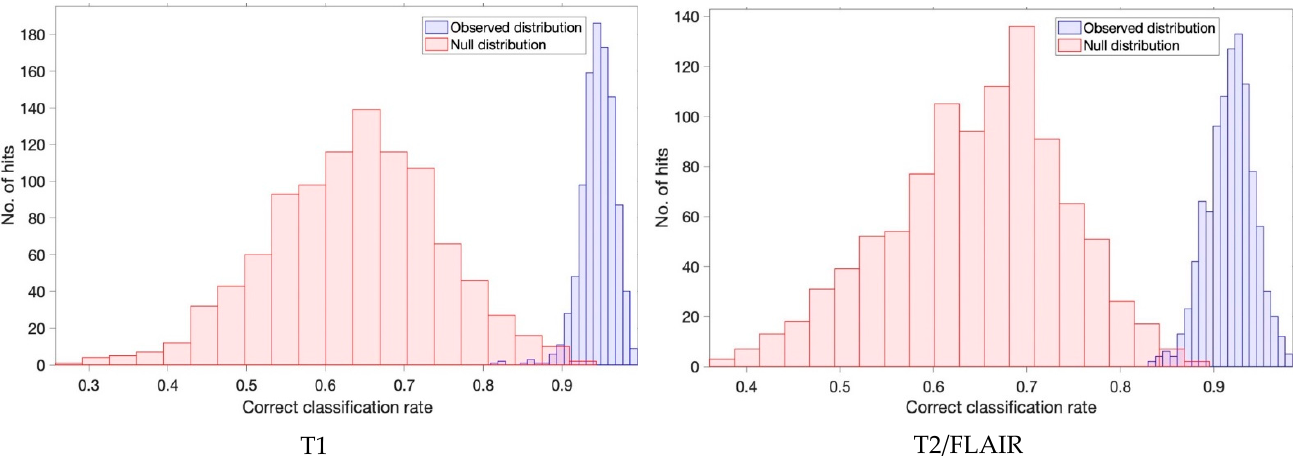
Figure 2. ROC curves with AUC for T1 and T2/FLAIR patient classification over nine repeats and 51 iterations with the partial least squares-discriminant analysis (PLS-DA) model.